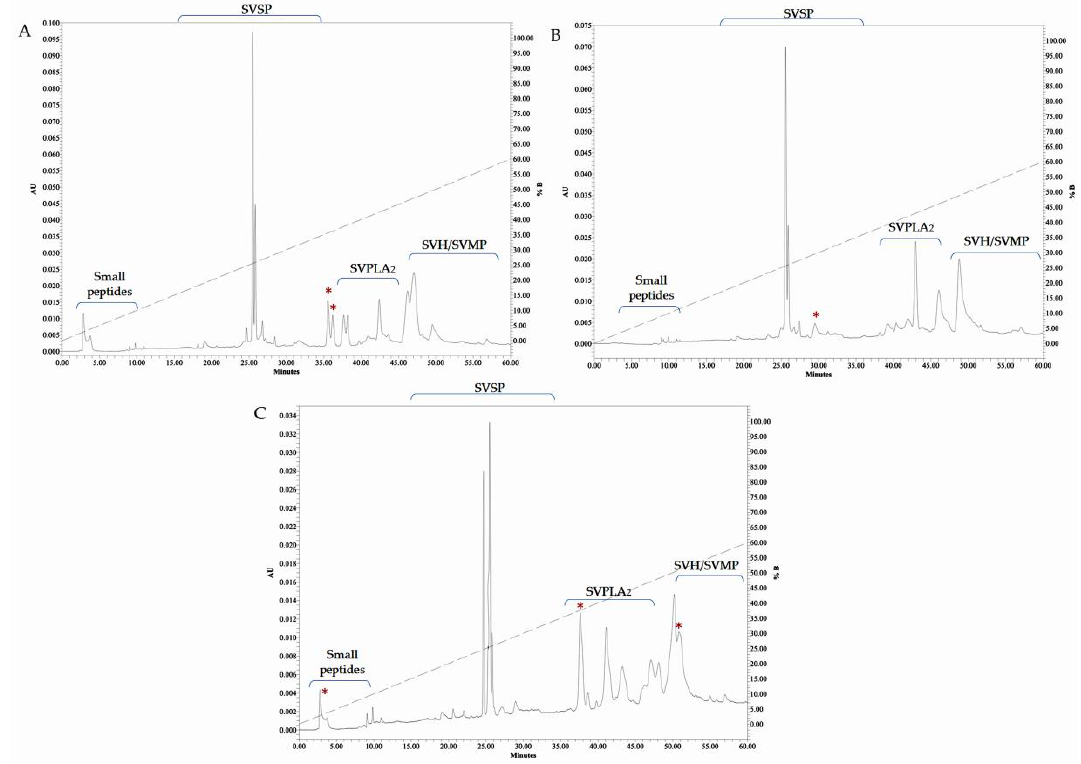
Figure 8. Venoms fractionation by RP–HPLC. Pooled crotalus venoms from ( A ) C. aquilus (Ca), ( B ) C. polystictus (Cp) and ( C ) C. molossus nigrescens (Cmn). Red asterisk show peaks not shared between the venoms. Snake venom serine proteases (SVSP), snake venom metalloproteases, (SVMP) and snake venom hyaluronidases (SVH). Absorbance units (AU) at 280 nm. Enzymatic activities were not determined, the family proposed for the enzymes are based on similarity of the elution profiles with reported data.